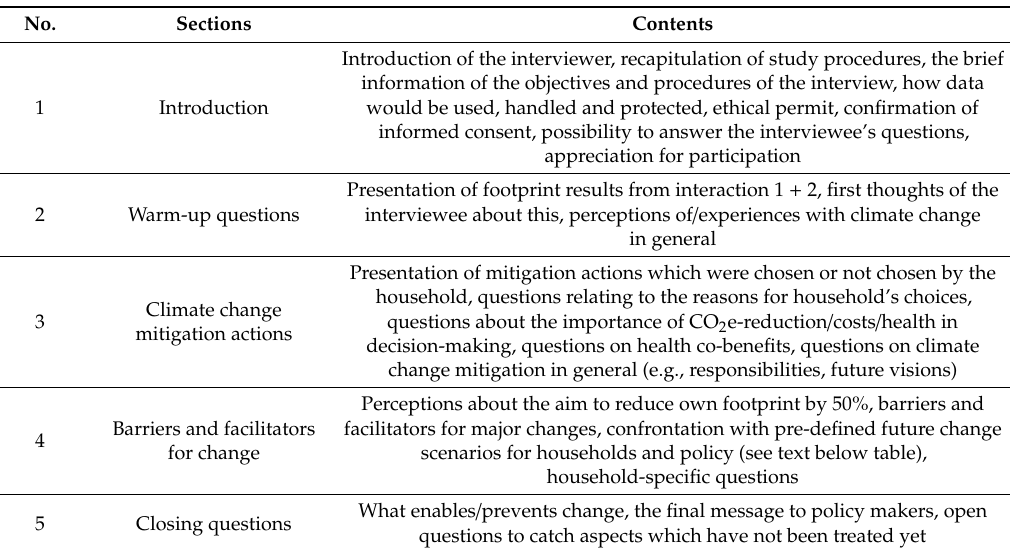
Table 1. Contents of the semi-structured interview